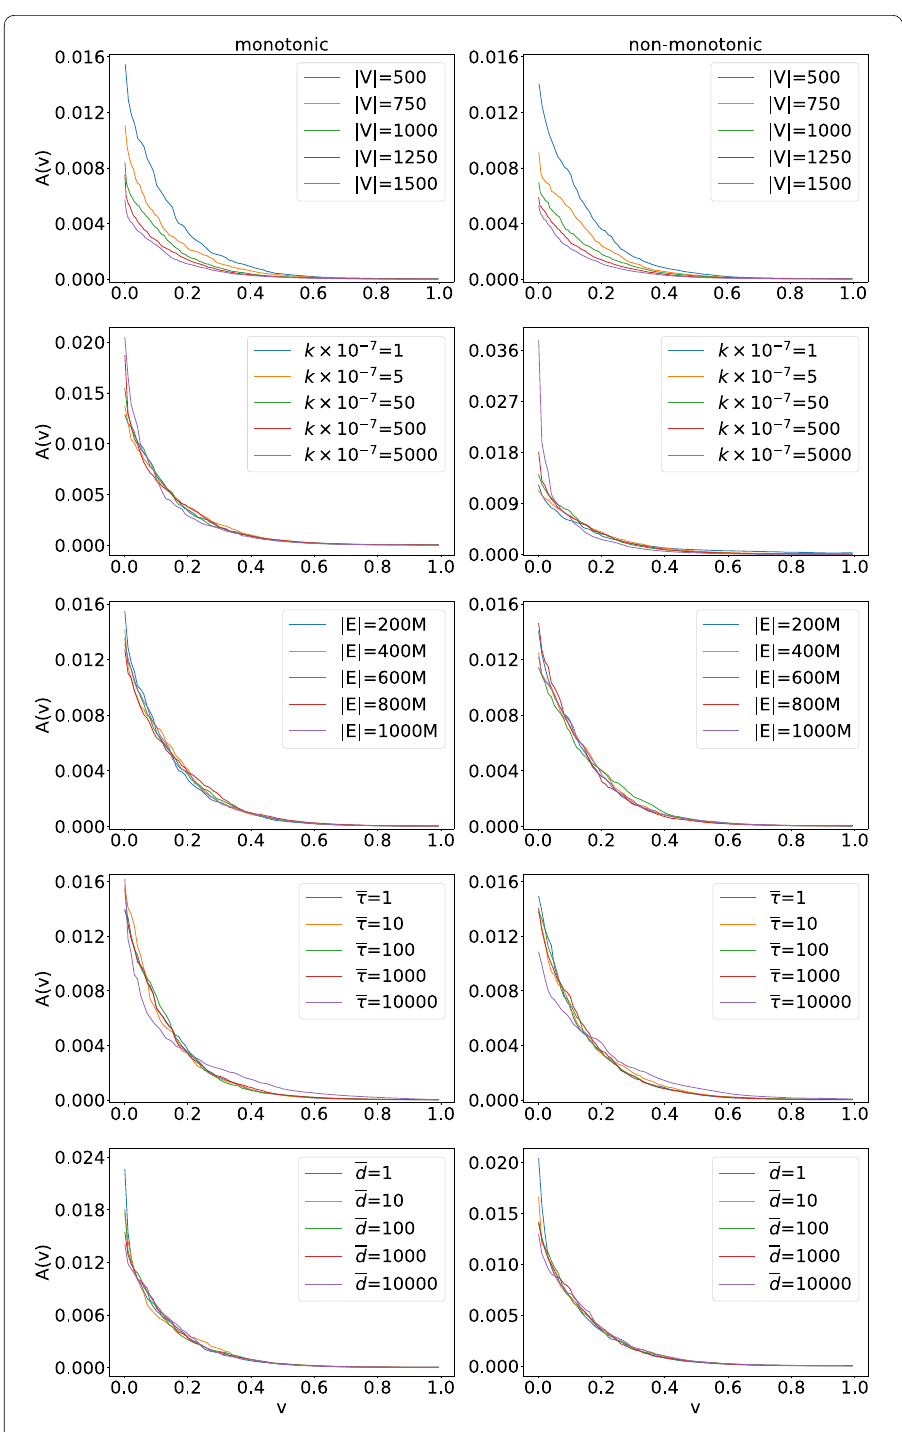
Figure 10 Relative degree in various networks. We note that (1) higher | V | , d tends to pull down the curve; (2) higher k tends to lifts the curve. (3) higher τ tends to pull down the front and lifts the